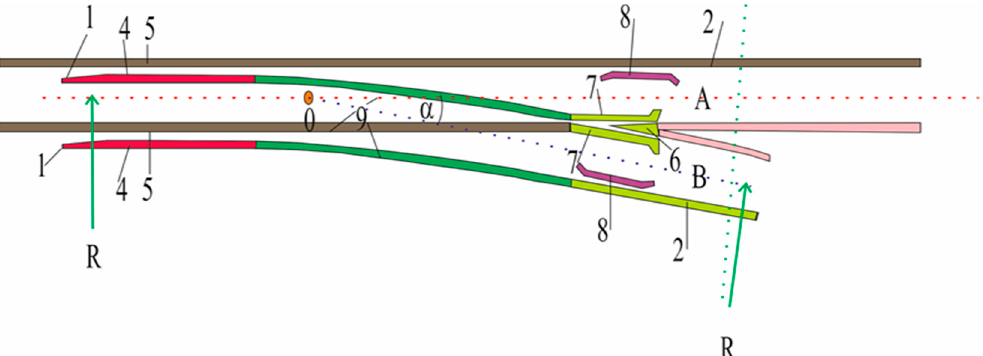
Figure 1. The basic components and geometrical elements of the regular turnout are: beginning of turnout 1 (in pre-switch contact point); end of turnout 2 (in contact point behind the frog); turnout geometric center, 0, which is the intersection of the stock rail axis with the closure rail axis; radius R of the closure rail curve; turnout angle α (angle between the axes of the stock rail and the closure rail), slant of the turnout—tangent α —expressed as a vulgar fraction with one in the numerator; switch points, 4; rheostats, 5; frog, 6; wing rails, 7; guard rails, 8; connecting rails, 9; AOB triangle. Turnouts for high-speed rail, V > 160 km / h, have curvature radii greater than 1000 m. In these turnouts, switch points have the following features; they are elastic elements with a permanently